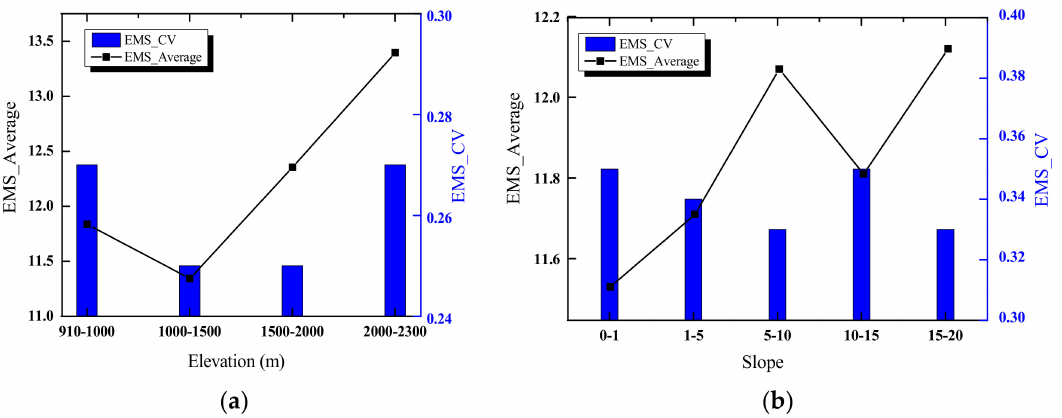
Figure 5. Statistical analysis of the index of landscape fragmentation at di ff erent elevation ( a ) and slope ( b